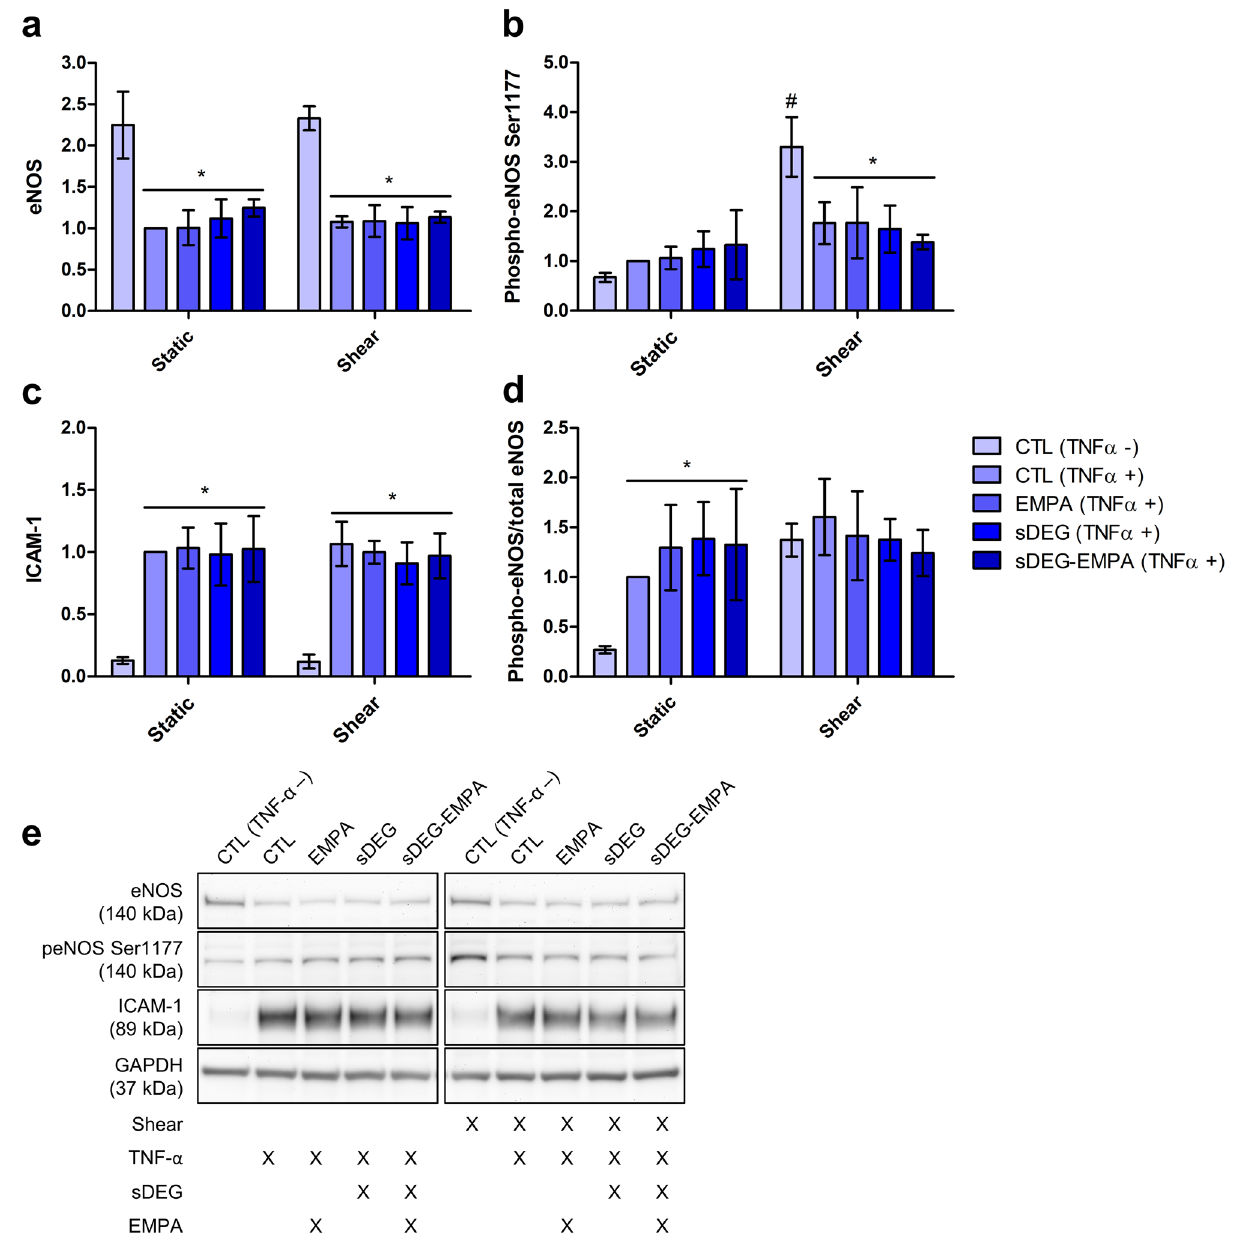
Figure 2. Protein expression quantification through western blot densitometry measurements after 24 h of culture. Expression of ( a ) eNOS, ( b ) phospho-eNOS Ser1177, ( c ) ICAM-1 and ( d ) the ratio phospho-eNOS/total eNOS were assessed. Shear increased the expression of phospho-eNOS Ser1177 compared to the static control (CTL TNF-α – shear vs CTL TNF-α – static # p < 0.001). TNF-α stimulation reduced expression levels of eNOS in static and shear culture and reduced phospho-eNOS Ser1177 in shear culture compared to TNF-α – controls (*p < 0.001). ICAM-1 expression was upregulated by TNF-α in static and shear culture compared to TNF-α – controls (*p < 0.001). Phospho-eNOS/total eNOS ratios were increased in static condition compared to the TNF-α – control (*p < 0.01) while no significant differences were observed in shear condition. No significant effects of degradation and EMPA were observed on the protein expression levels within TNF-α groups. ( e ) Representative bands and culture condition details. Full-length blots can be found in the Supplementary Fig.